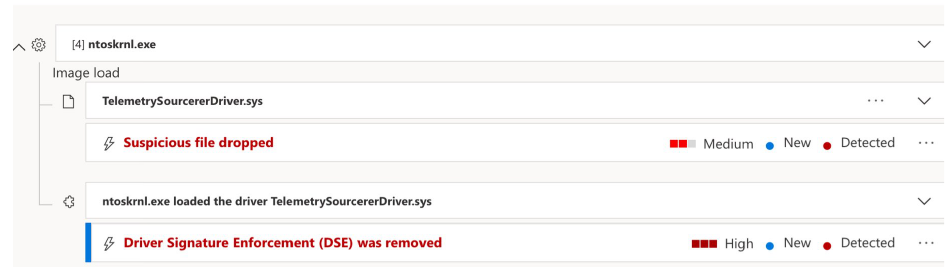
Figure 31. DSE Alert by ATP. Telemetry Sourcerer driver